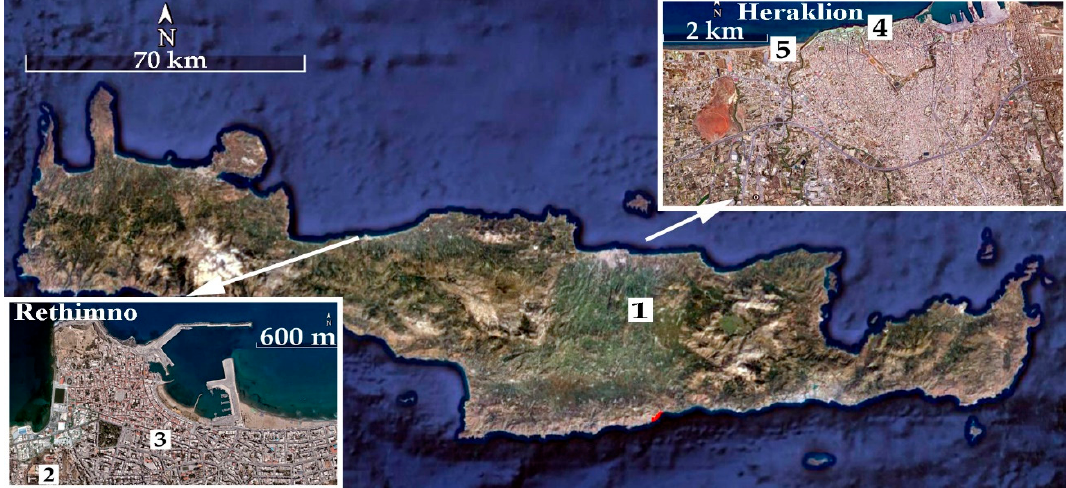
Figure 2. The location of the investigated buildings in the towns of Heraklion and Rethimno.